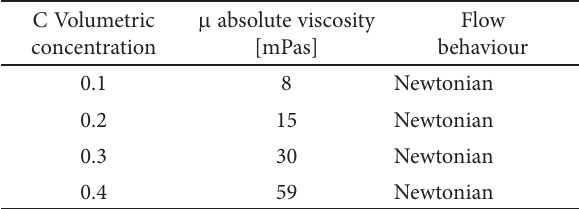
Table 12. Flow properties of perlite – water